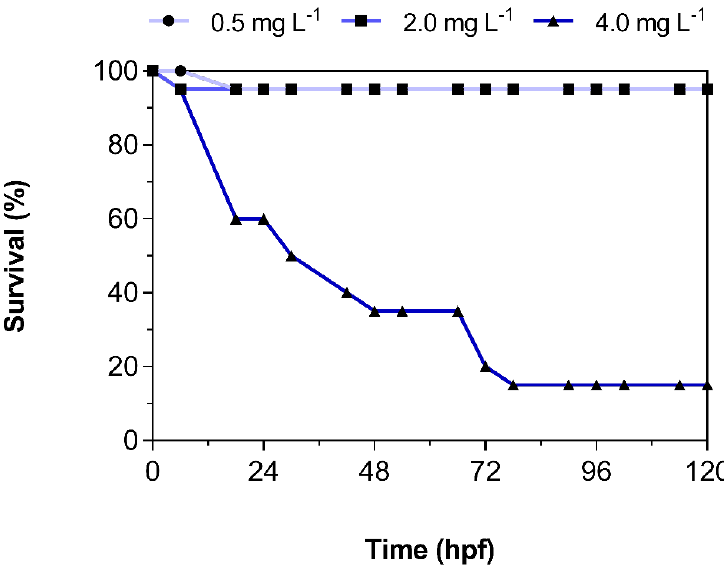
Figure 1. Percent survival of zebrafish embryolarval life stages exposed to 0.5, 2.0, and 4.0 mg L − 1 3,4-dichloroaniline (3,4-DCA). Data represent the average of n = 2 independent replicates.